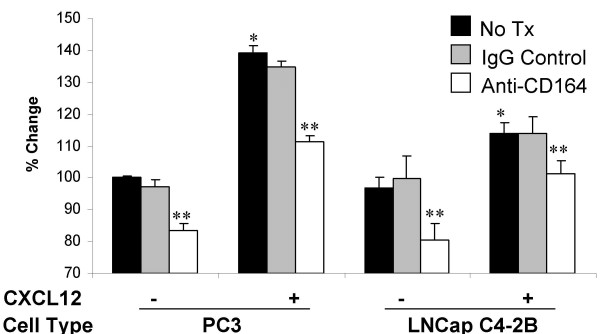
CD164 regulates CaP cell invasion. Cell invasion into a reconstituted extracellular matrix was performed using two chambered invasion plates (BD Biosciences, San Jose, CA). PC3 and LNCaP C4-2B cells were placed in the upper chamber (1 × 105 cells/well) in serum free medium. Spontaneous invasion was compared to invasion supported by a CXCL12 200 ng/ml gradient [32]. Where indicated, IgG control or mouse anti-human CD164 monoclonal antibody (50 μg/ml, Clone N6B6, BD PharMingen) was added at the start of the investigation to each chamber. At the termination of the assay (24 h), the invasion was quantified by MTT. * Indicates significant difference from vehicle treated cells (no CXCL12), and ** indicates significant difference from IgG treated controls at p < 0.05. The data demonstrate that anti-CD164 inhibits invasion of CaP cells